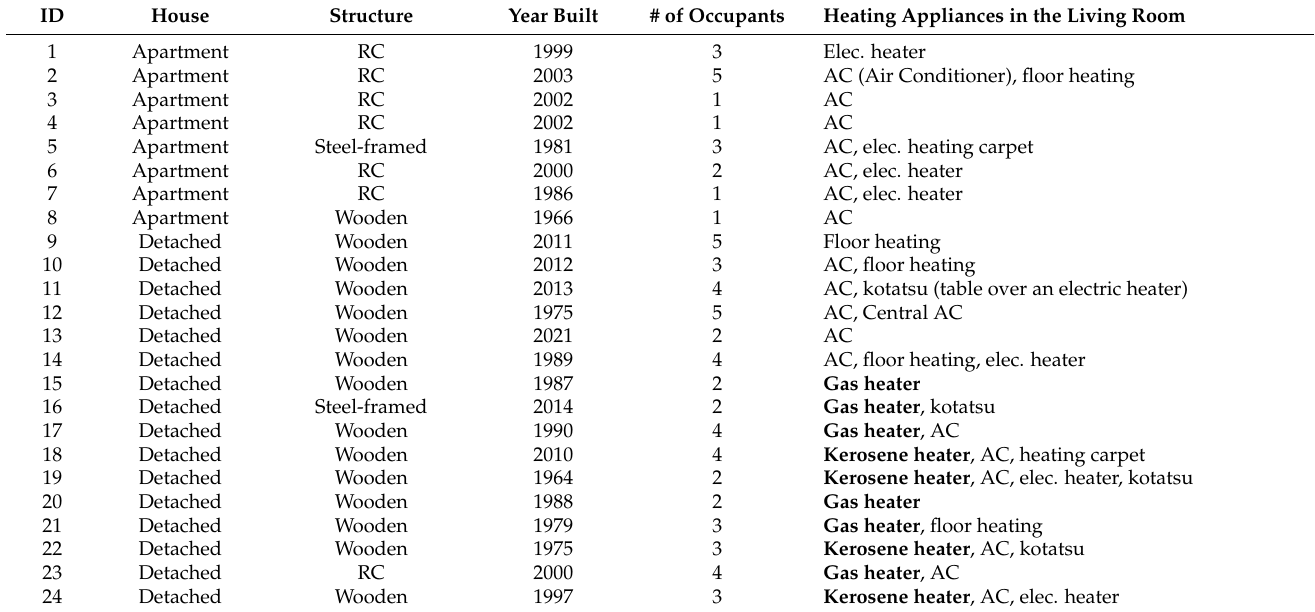
Table 2. Characteristics of research participants for the experiments.